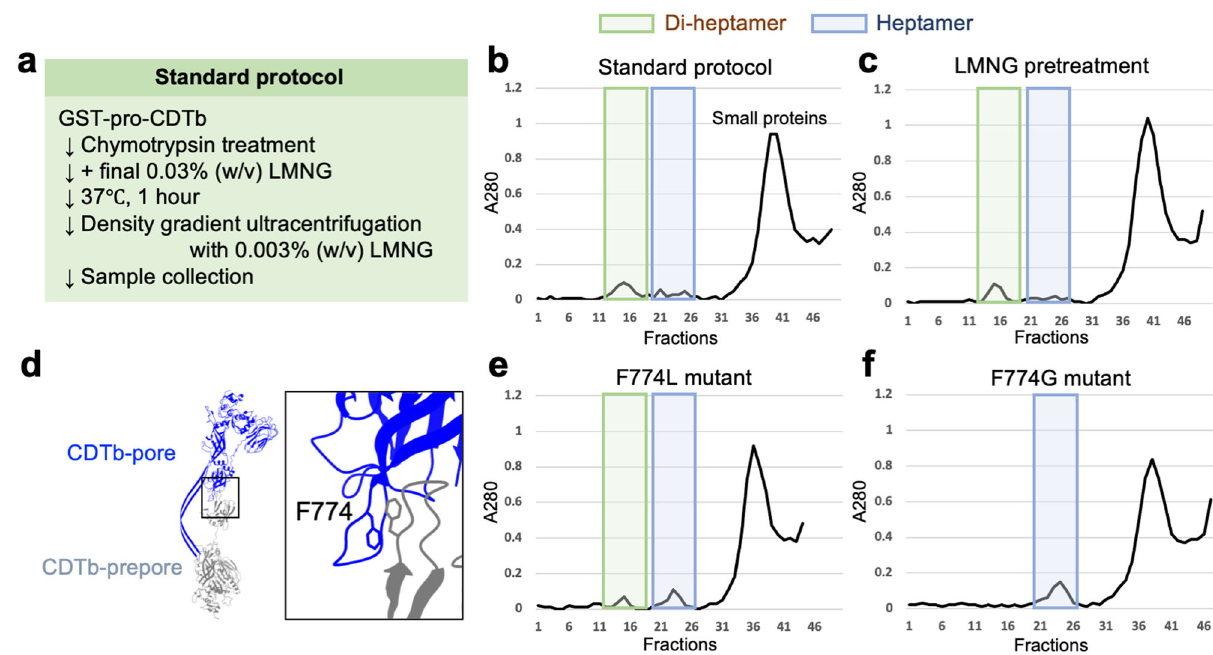
Fig. 1 | CDTb puri fi cation. a Protocol diagram. b Density gradient without LMNG pretreatment. c Density gradient with LMNG pretreatment before chymotrypsin treatment. d Location of CDTb residue F774 involved in di-heptamer formation.